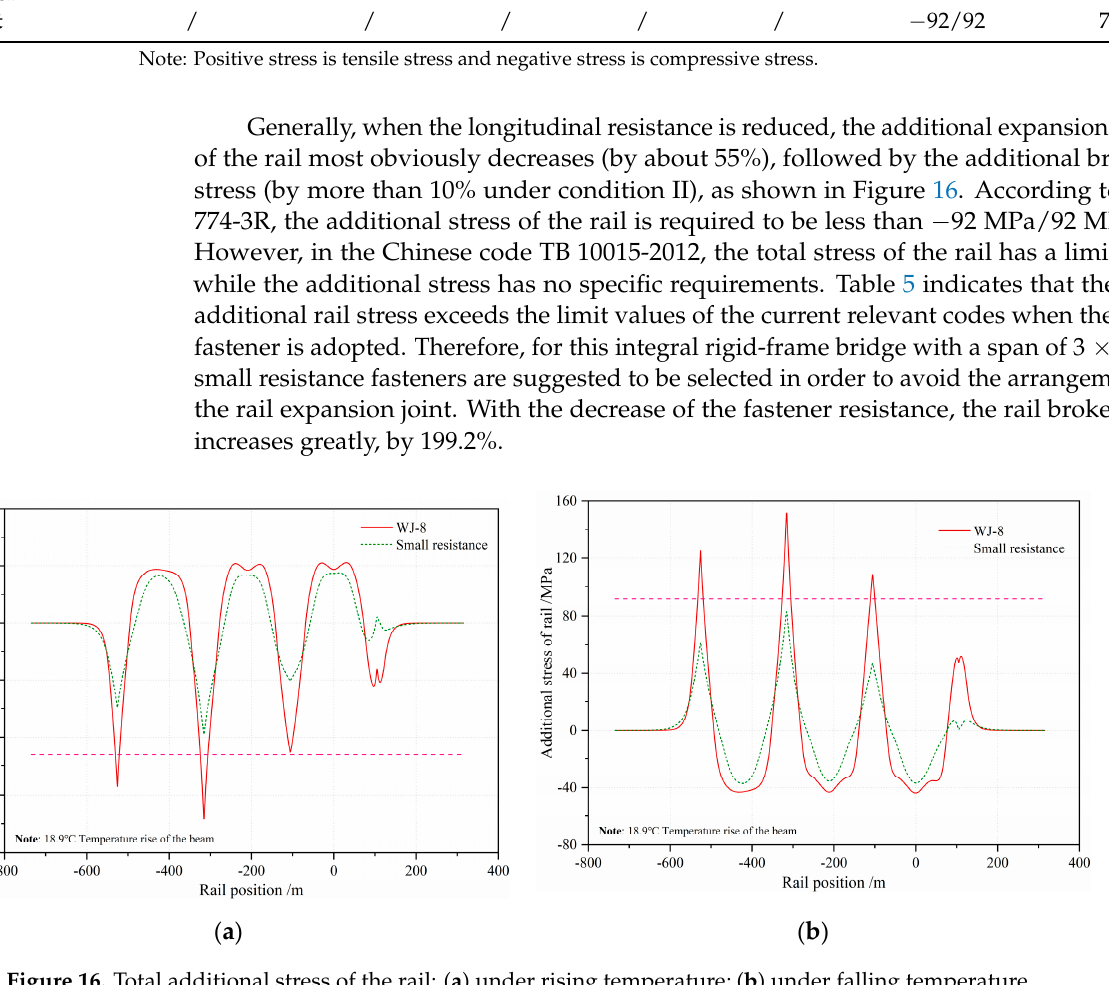
Figure 16. Total additional stress of the rail: ( a ) under rising temperature; ( b ) under falling temperature.